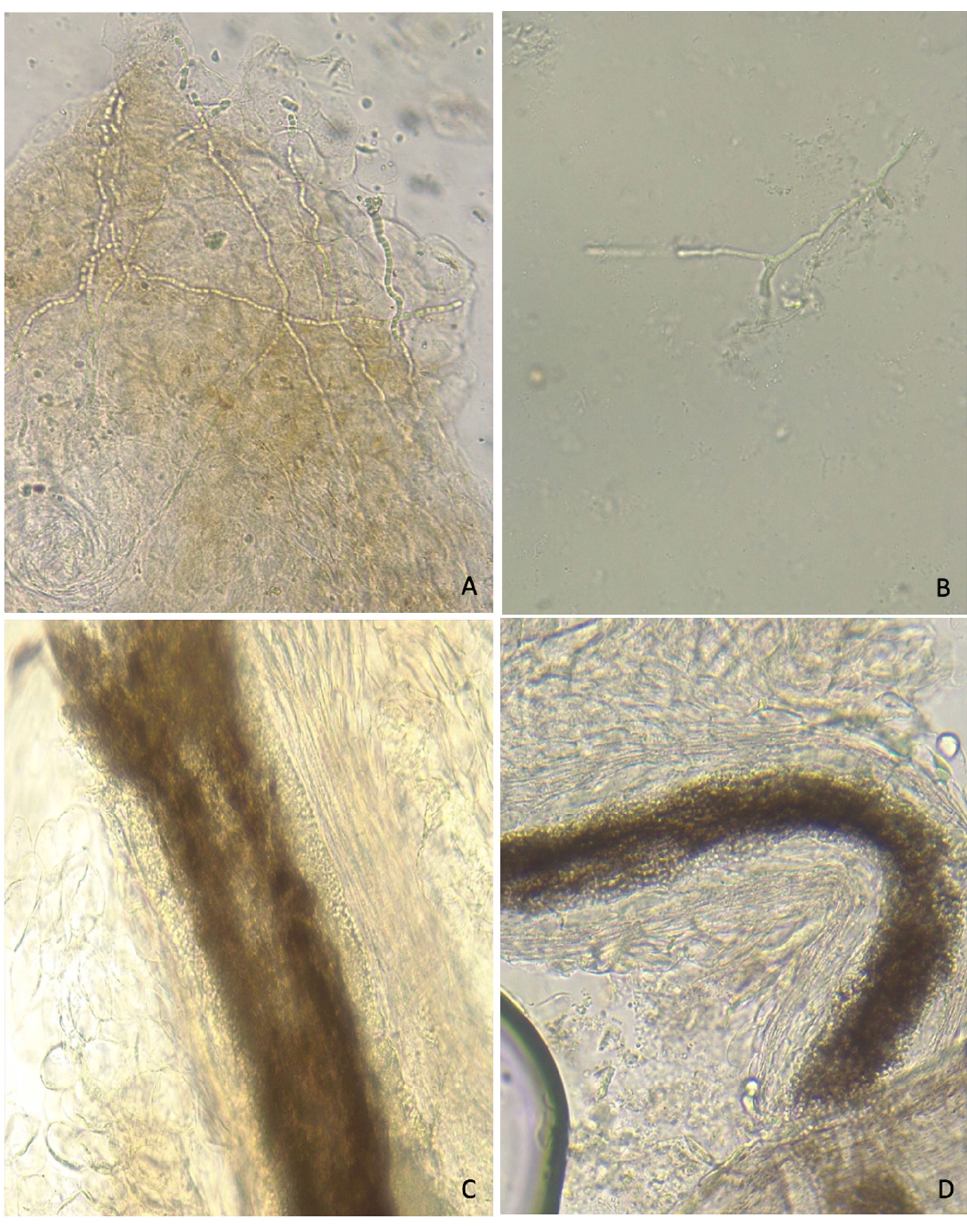
Figure 2. Direct microscopic examination of scales ( top ) or hair ( bottom ) samples. Panel ( A ) dermatophyte-like hyphae formed by chain of arthroconidia; panel ( B ) Fusarium -like hyphae with a “dead wood” appearance; panel ( C ) endo-ectothrix hair shaft dermatophyte infection; panel ( D ) endothrix hair shaft dermatophyte infection. Table 1. Positive results of direct microscopic examination and culture ( n = 105).